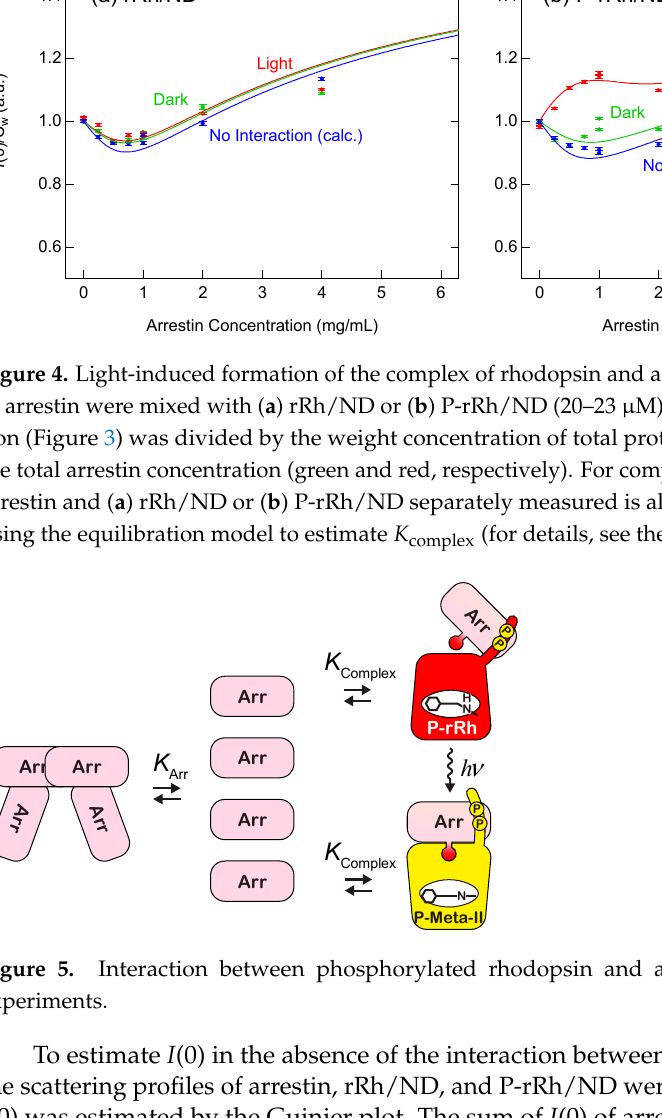
Table 1. Dissociation constants of the arrestin tetramer and the rhodopsin/arrestin complex.